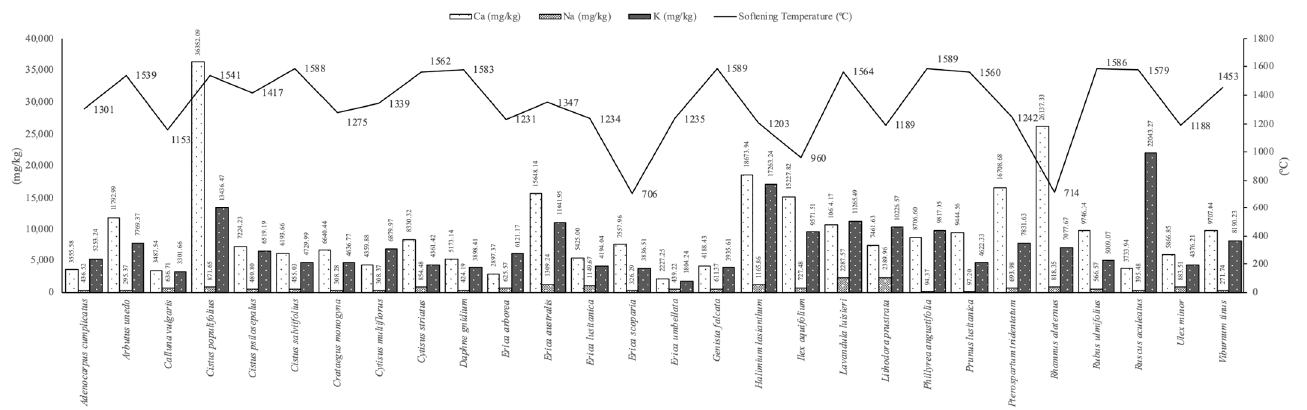
Figure 13. Content of Ca, Na and K (mg/kg) and softening temperature (°C).